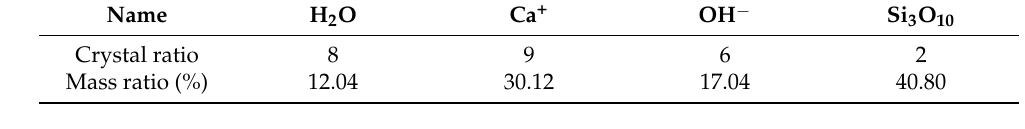
Figure 6. The molecular model of C-S-H gel components. ( a ) H 2 O molecular model; ( b ) Ca + ion model; ( c ) OH − ion model; ( d ) Si 3 O 10 molecular model. Figure 5. SEM image of C-S-H [37]. Table 2. Proportions of C-S-H gel composition.